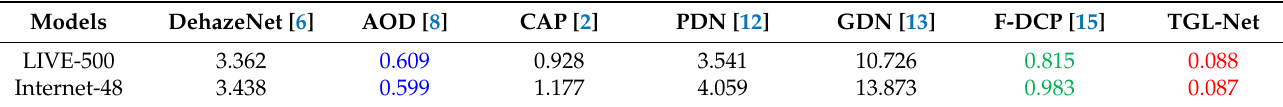
Table 7. Average run time (in seconds) on the LIVE-500 and Internet-48 testing sets.